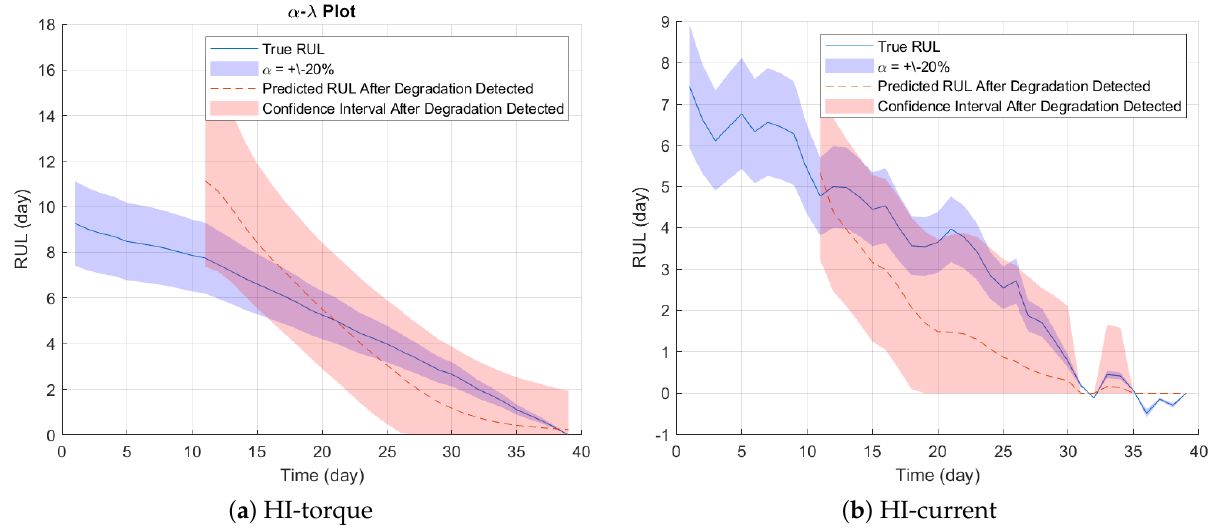
Figure 10. RUL prediction performance of the proposed approach based on HI-torque and HI-current.